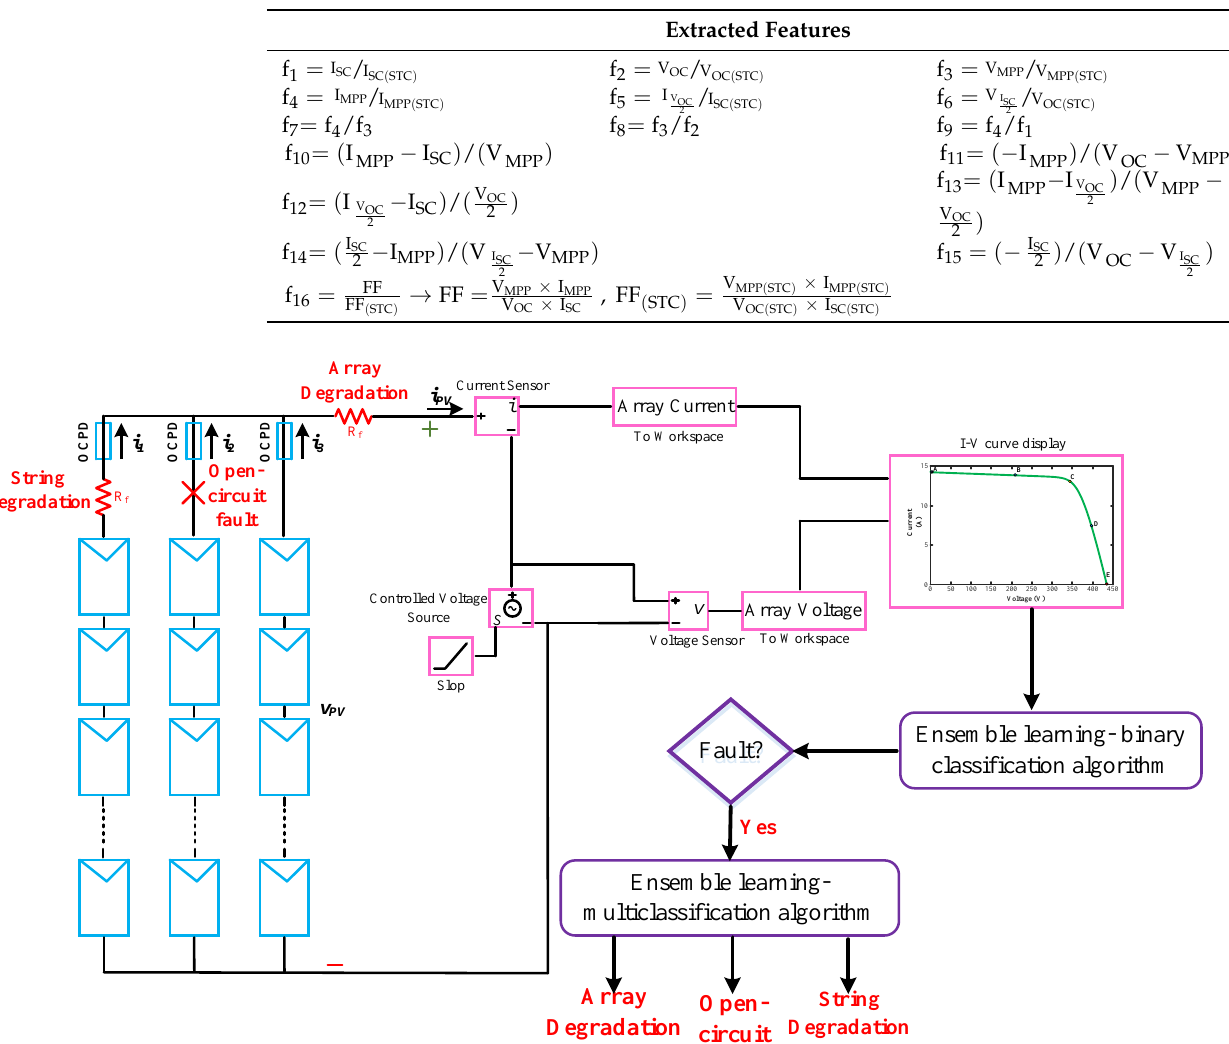
Table 2. Extracted features from current-voltage curves.